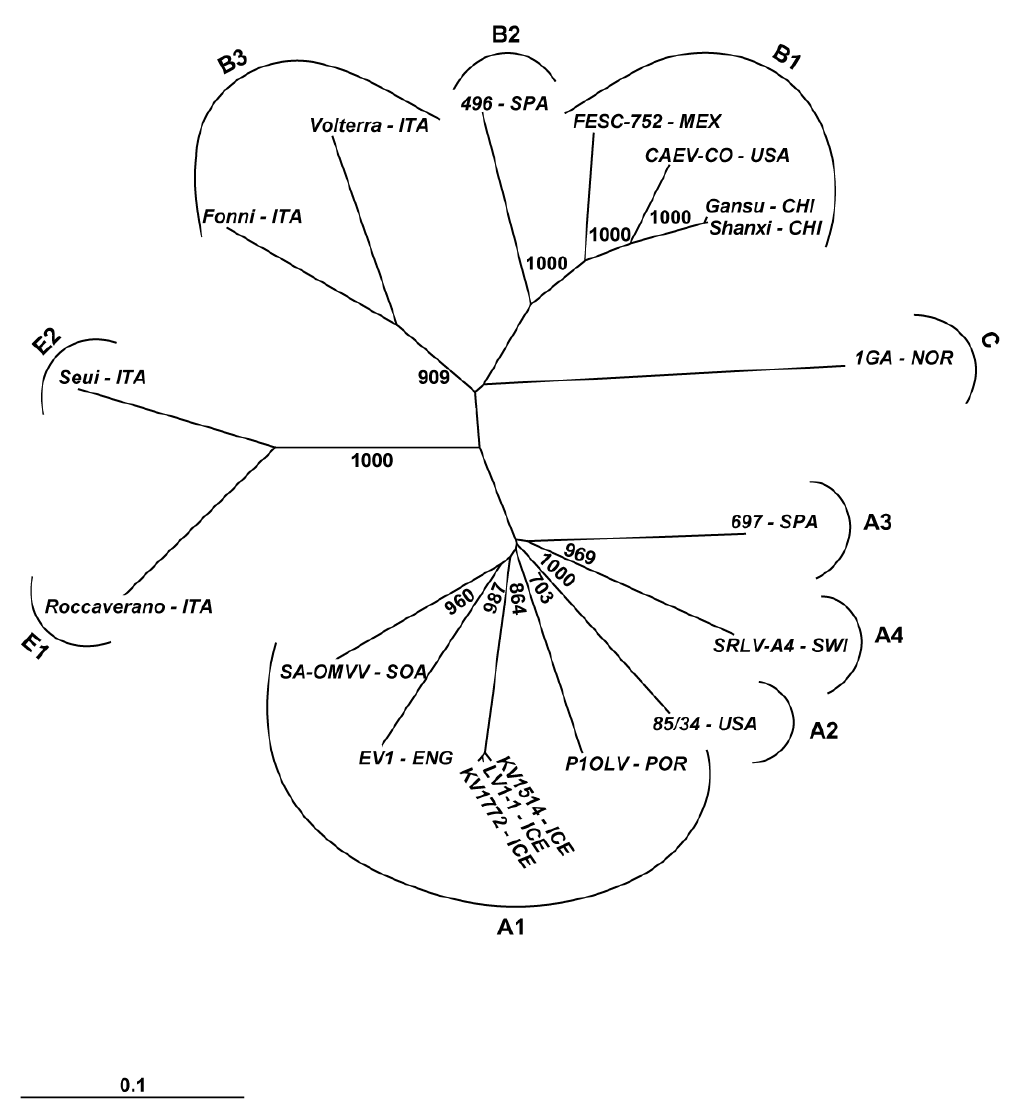
Figure 1. Phylogenetic tree involving SRLV complete sequences obtained from GenBank (accession numbers in bold and underlined) that include the name of isolate and country origin. Country abbreviations: CHI - China (Gansu AY900630 and Shanxi GU120138 ); ENG - England (EV1 S51392 ); ICE - Iceland (KV1514 M60610 , LV1 M10608 and KV1772 L06906 ); ITA - Italy (Roccaverano EU293537 , Seui GQ381130 , Fonni JF502416 and Volterra JF502417 ); MEX - Mexico (FESC-752 HM210570 ); NOR